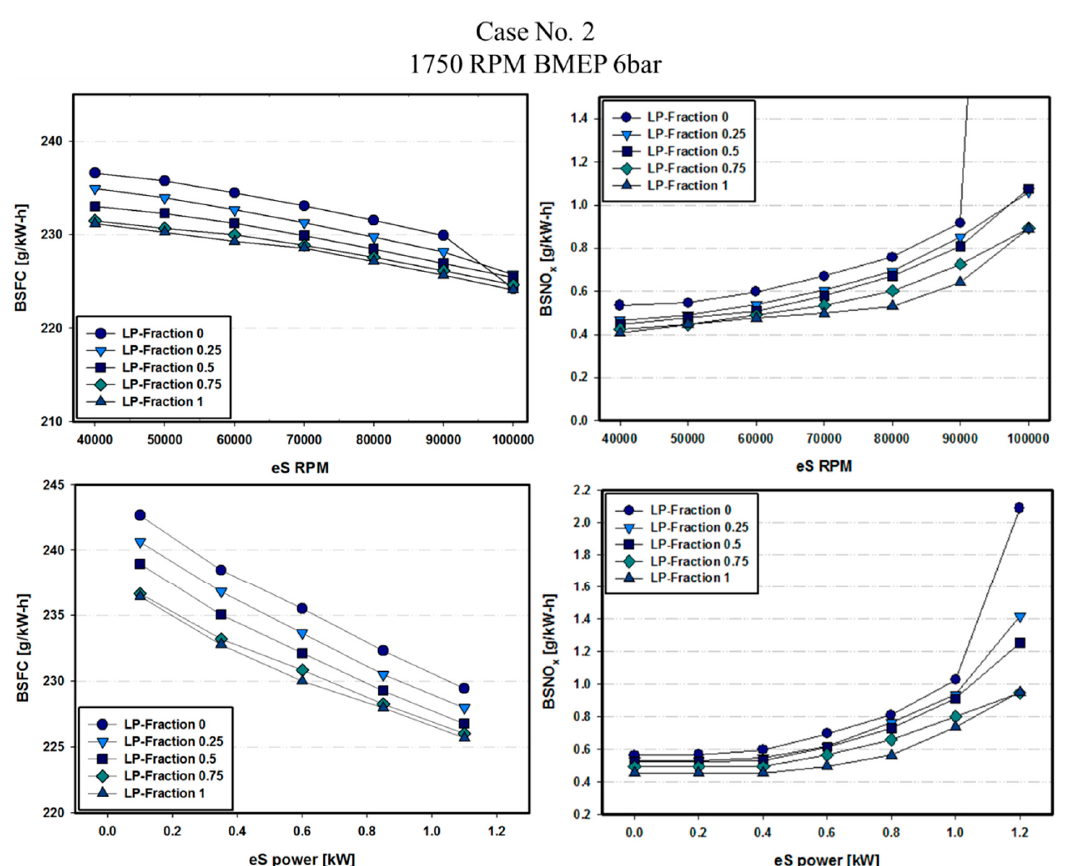
Figure 9. BSFC and BSNO x di ff erences due to eS rpm and power increases in case 2.